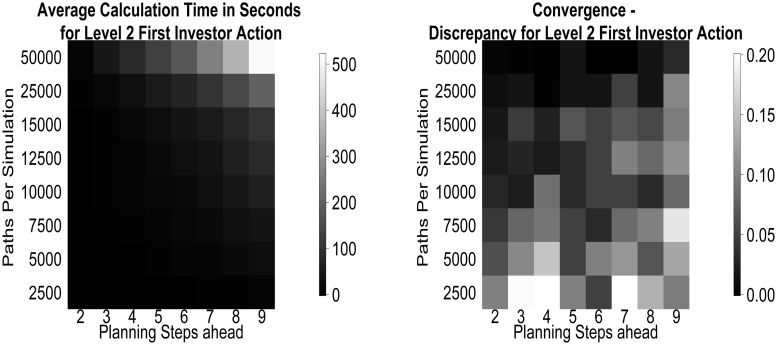
Numerical properties.(left) Average running times for calculating the first action value of a level 2, guilt 1 investor from a given number of simulations, as a function of planning horizon (complexity). (right) Discrepancy to the converged case of the action probabilities for the first action measured in squared discrepancies.